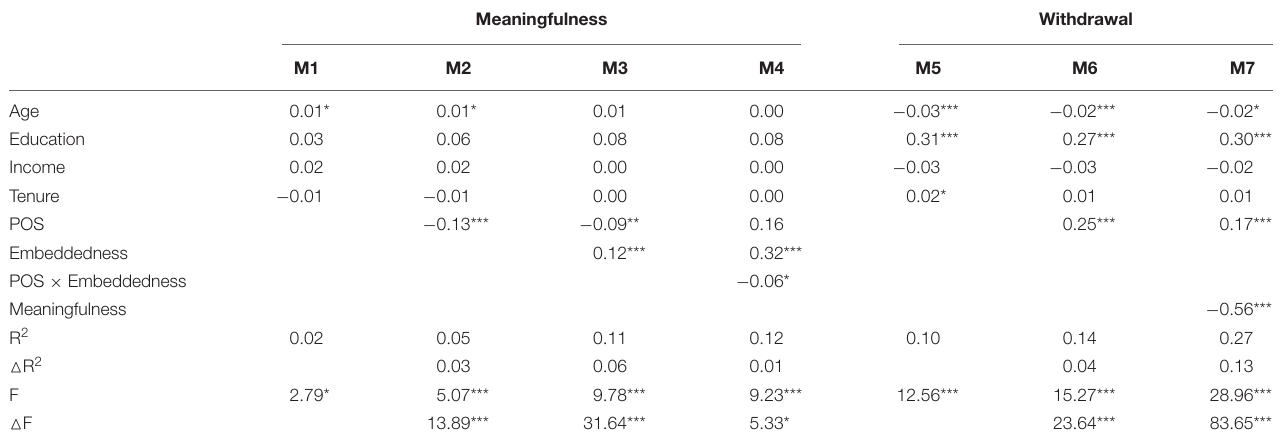
TABLE 2 | Results of multiple regression